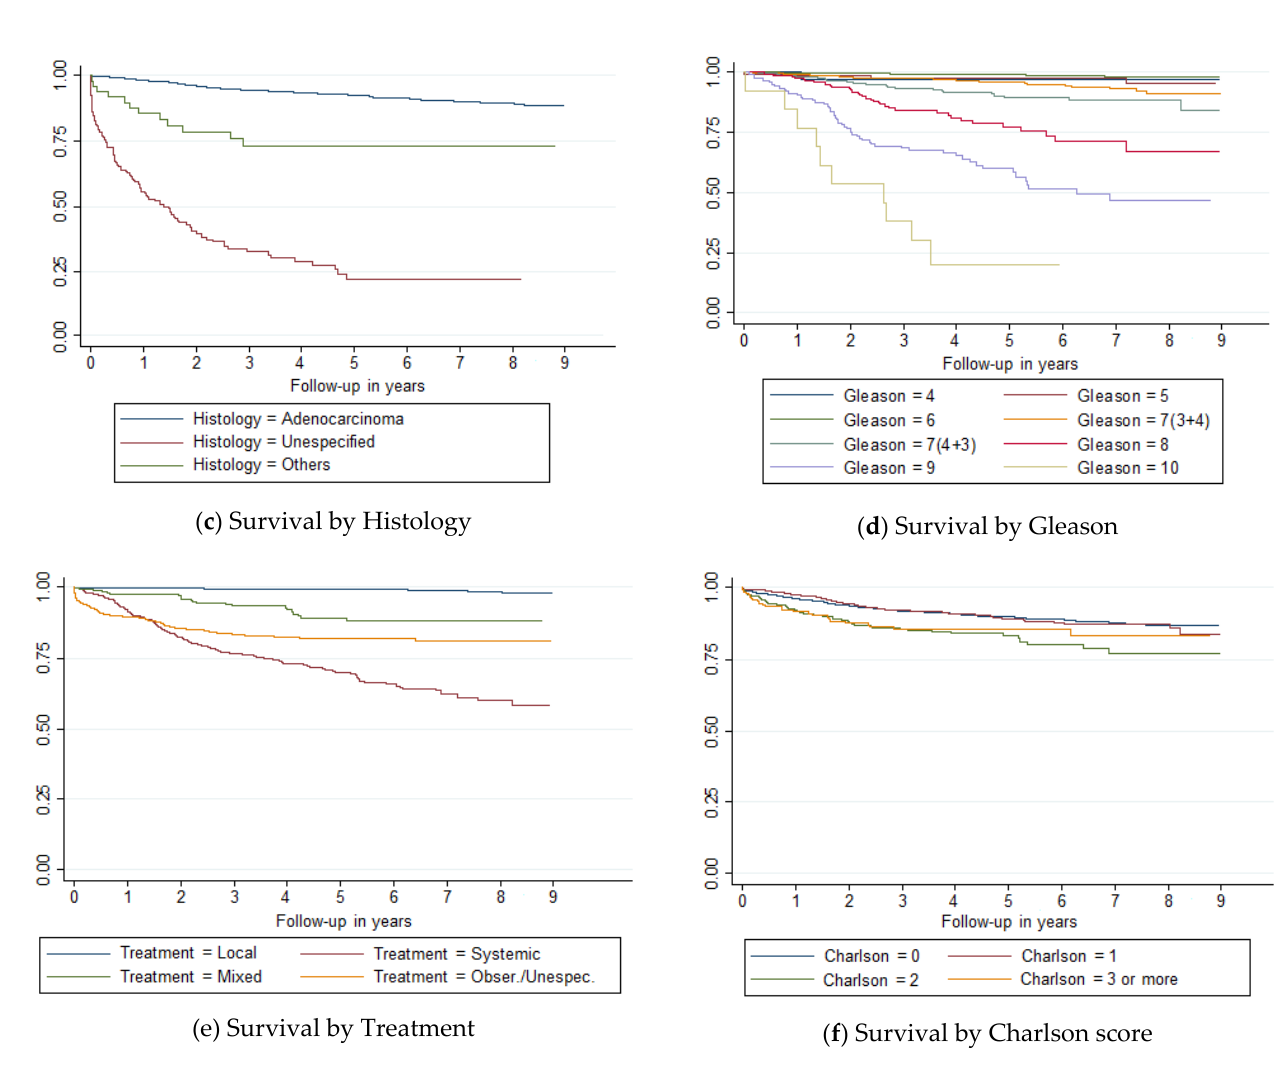
Figure 1. Survival curves of prostate cancer cases diagnosed in Mallorca between 2006 and 2011 by ( a ) age, ( b ) risk, ( c ) histology, ( d ) Gleason, ( e ) treatment and ( f ) Charlson score. Table 5. Competing-risks regression model of prostate cancer diagnosed in Mallorca between 2006 and 2011 before (Model 1) and after (Model 2) multiple imputation (m =